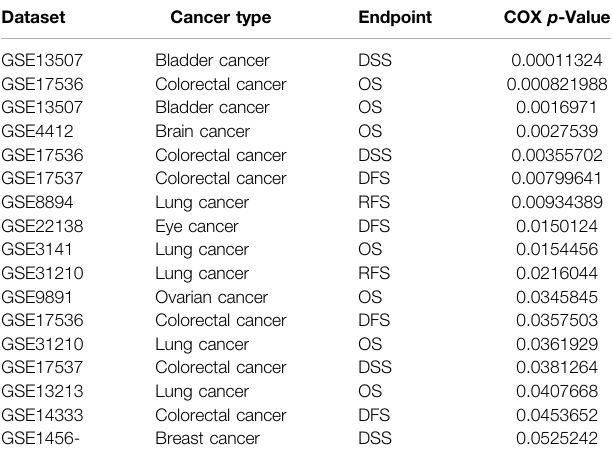
TABLE 1 | The prognosis of IQGAP3 in pan-cancer analysis by using the prognostic database.